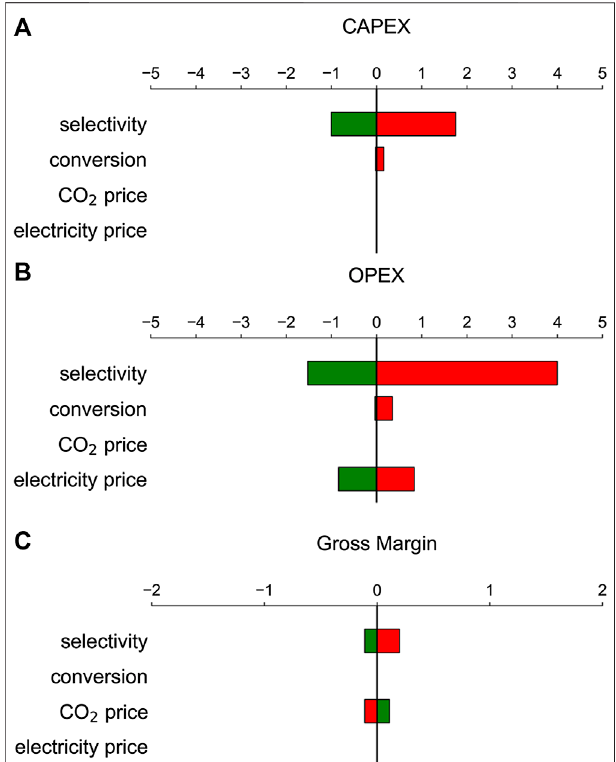
FIGURE 8 | Sensitivity analysis of the (A) Capital expenditure (CAPEX), (B) Operational expenditure (OPEX), and (C) gross margin for a positive (green) or negative (red) change of the model parameters (selectivity, conversion, CO 2 price and electricity price) for the reference electrochemical